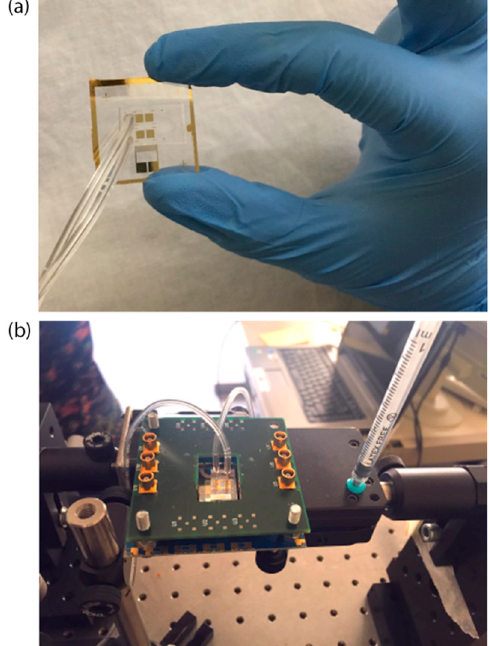
Figure 3. Picture of the sensor chip alone ( a ) and mounted on the holder with the printed circuit board (PCB) used to excite the SAWs ( b ) Tygon tubes are connected to a syringe (inlet) and to a waste beaker (outlet).